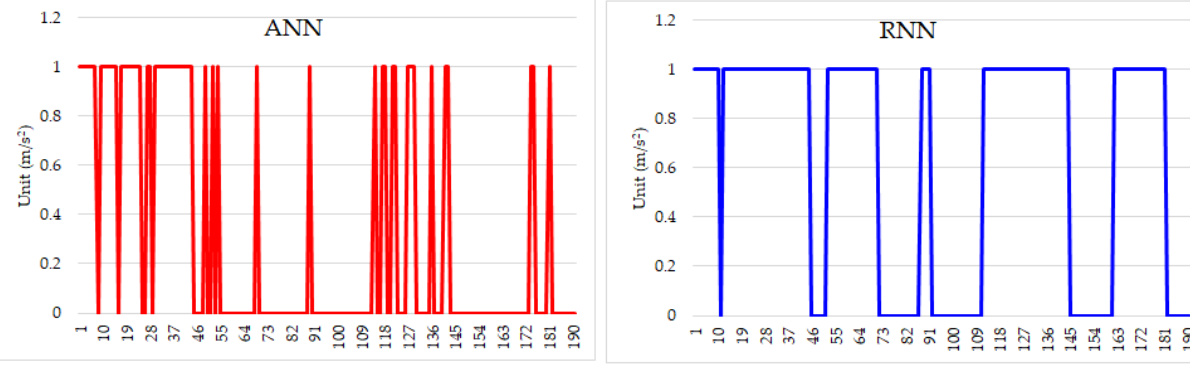
Figure 9. ANN vs. RNN.